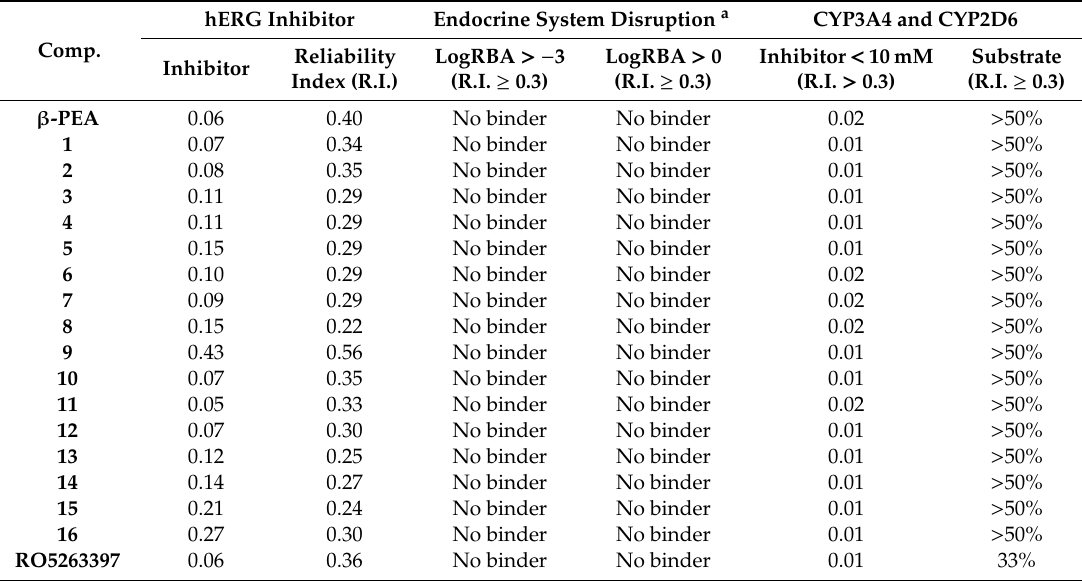
a RBA: relative binding a ffi nity with respect to that of estradiol. Compounds showing LogRBA > 0 are classified as strong estrogen binders, while those showing LogRBA < − 3 are considered as non-binders. (RI: reliability index. Borderline-allowed values for reliability parameter are ≥ 0.3; the most predictive fall in the range